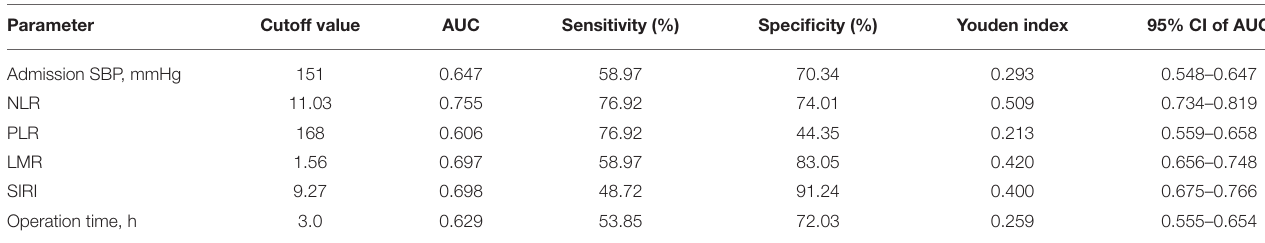
TABLE 1 | The cutoff value and area under the curve of the possible predictive factors of postoperative tracheostomy in training cohort. Parameter Cutoff value AUC Sensitivity (%) Specificity (%) Youden index 95% CI of AUC Admission SBP,